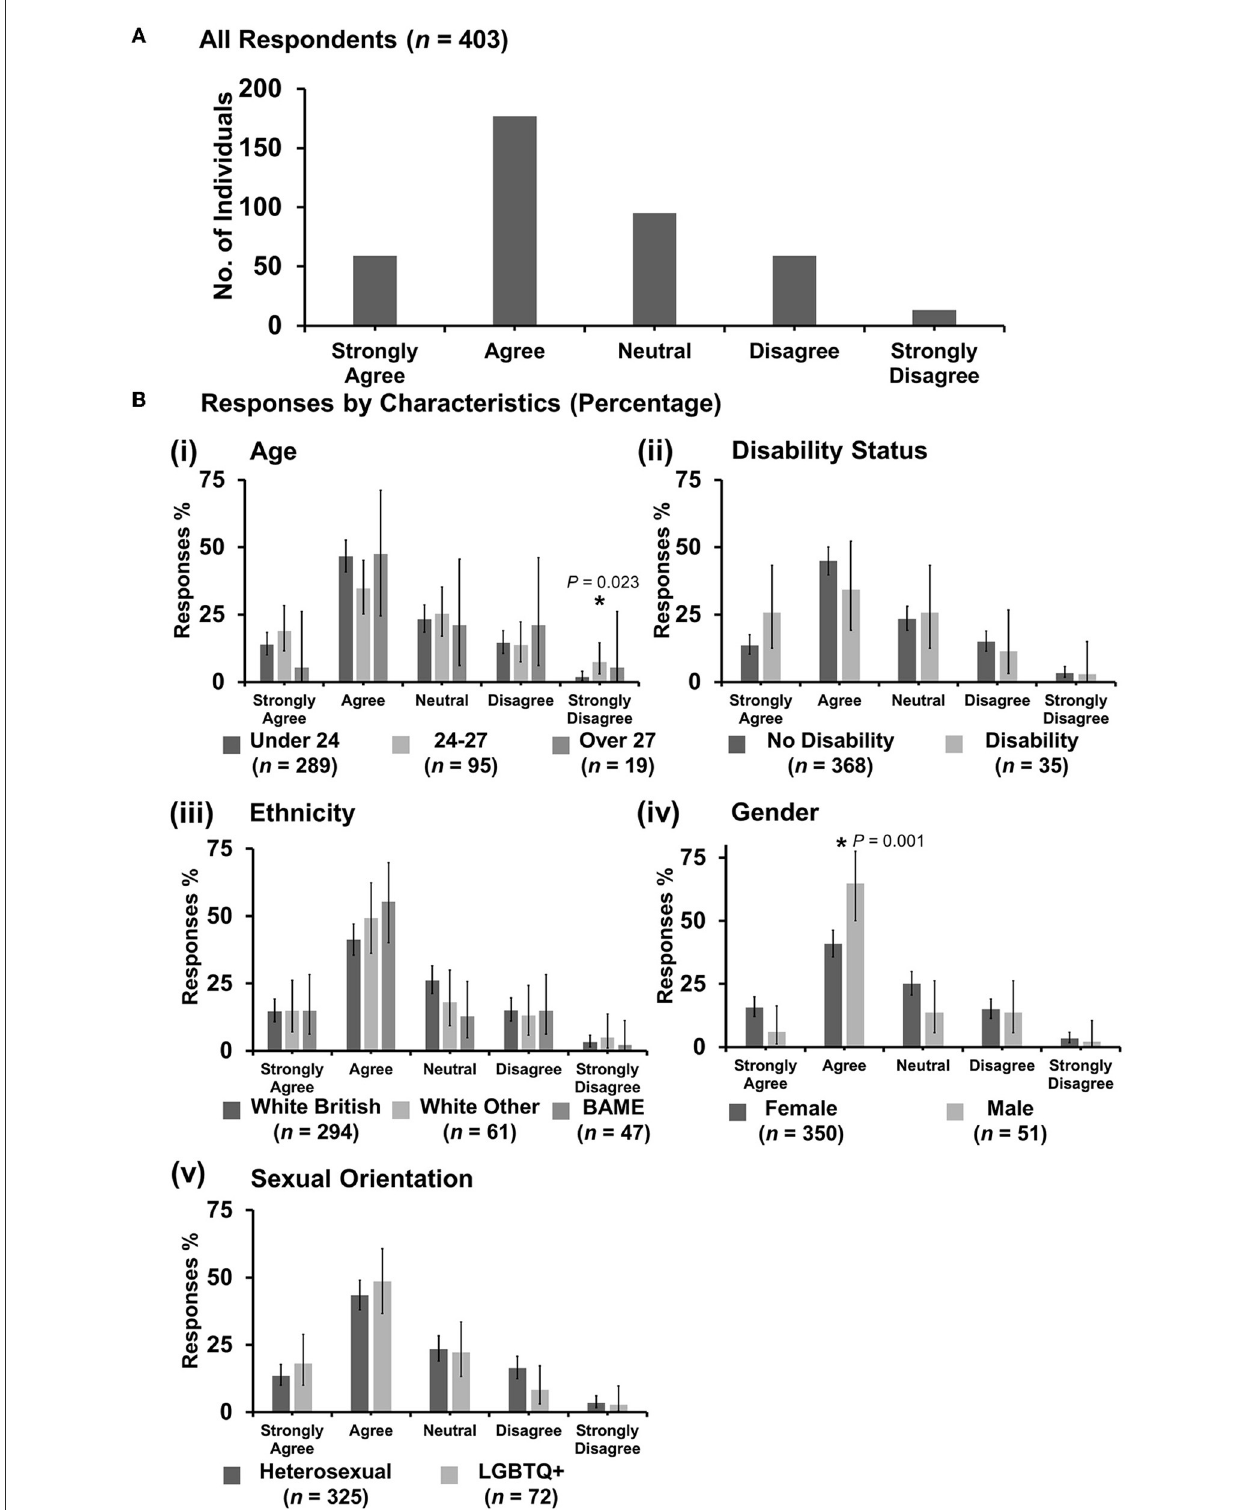
FIGURE13 Likert scale selections for the statement: veterinary students are more vulnerable to discrimination than qualified veterinary surgeons/veterinary professionals. (A) Bar graph demonstrating the number of respondents selecting each Likert scale response. [ (B) i–v] Bar graphs demonstrating by percentage proportion the number of responses in each Likert category by the group under the demographic categories of age, disability status, ethnicity, gender, and sexual orientation. Error bars represent 95% confidence intervals calculated by the Binomial “Exact” method. Statistical significance was determined by Pearson’s chi-squared test of association between respondent’s group under category and Likert scale selection. * P <